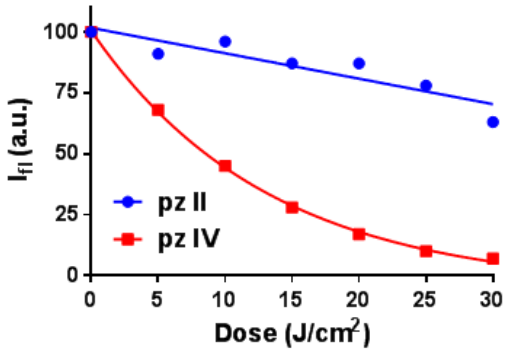
Figure 3. Photobleaching of pz II and pz IV in ethanol–glycerol solutions with a viscosity of 30 cP induced by irradiation with power density 20 mW/cm 2 .